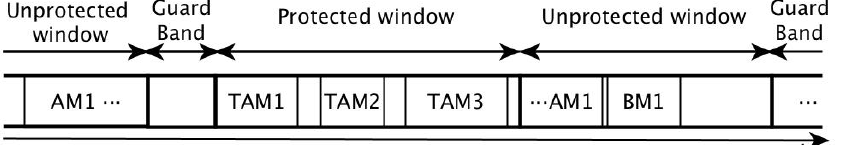
Figure 1. A communication cycle example divided into a protected window, an unprotected window and a guard